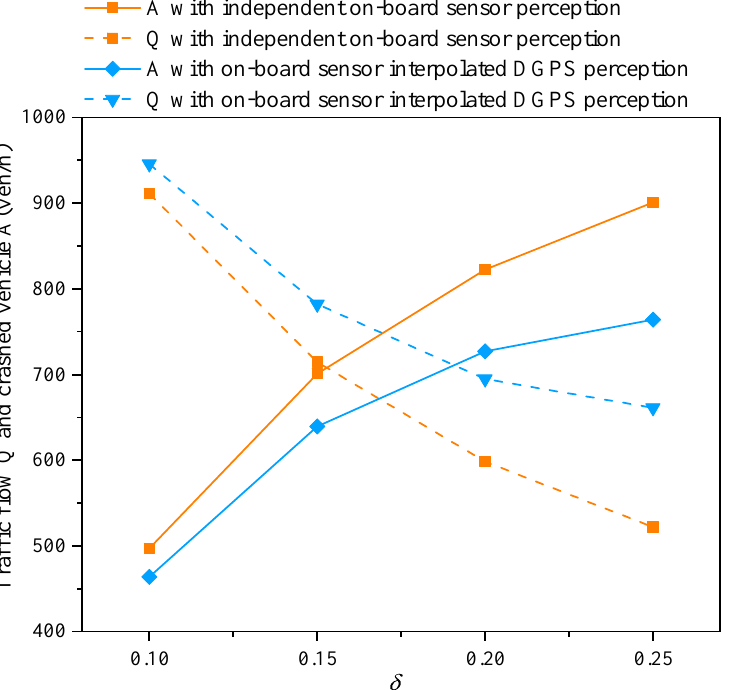
Figure 6. Traffic flow and crashed vehicles for varying perceptual error size δ with an independent on-board sensor perception scheme and on-board sensor interpolated DGPS perception scheme in a completely CAV